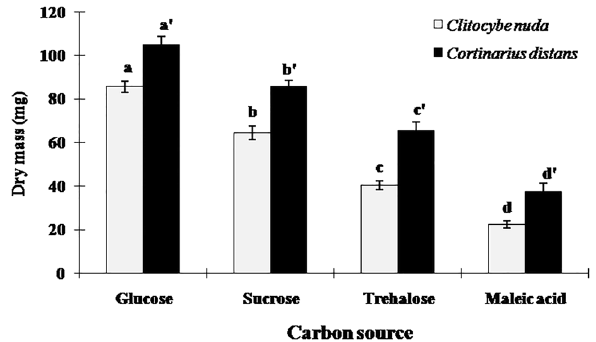
Figure 1. Dry mass (Mean ± SE) of ECM fungi in liquid media containing different C sources. Different letters on the bars indicate that the means are significantly different (Tukey’s HSD test, P < 0.05).